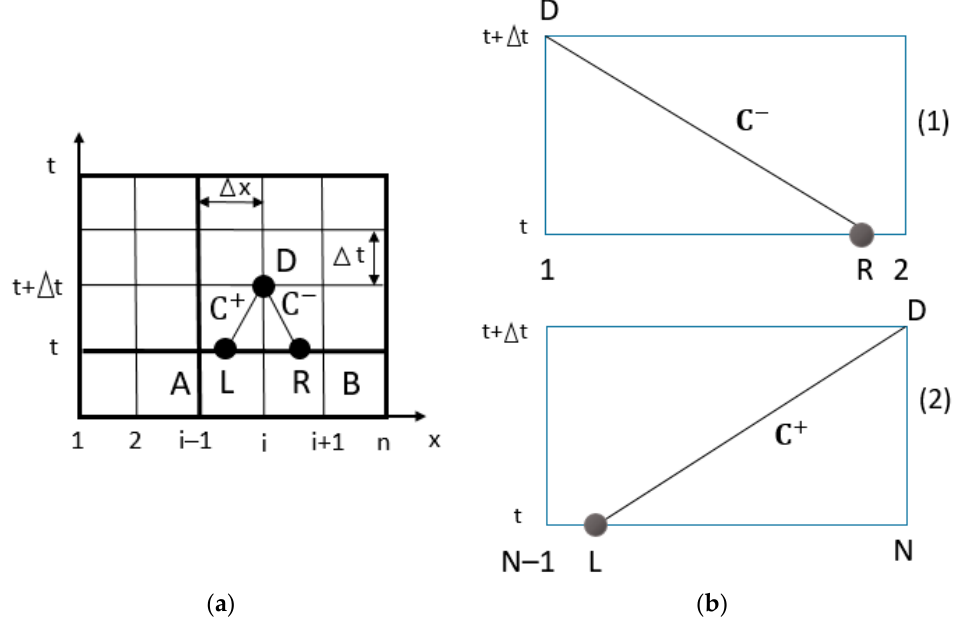
Figure 6. Method of characteristics ( a ) Schematic of characteristic line for MOC; ( b ) Calculation schemes of the first and the last points.